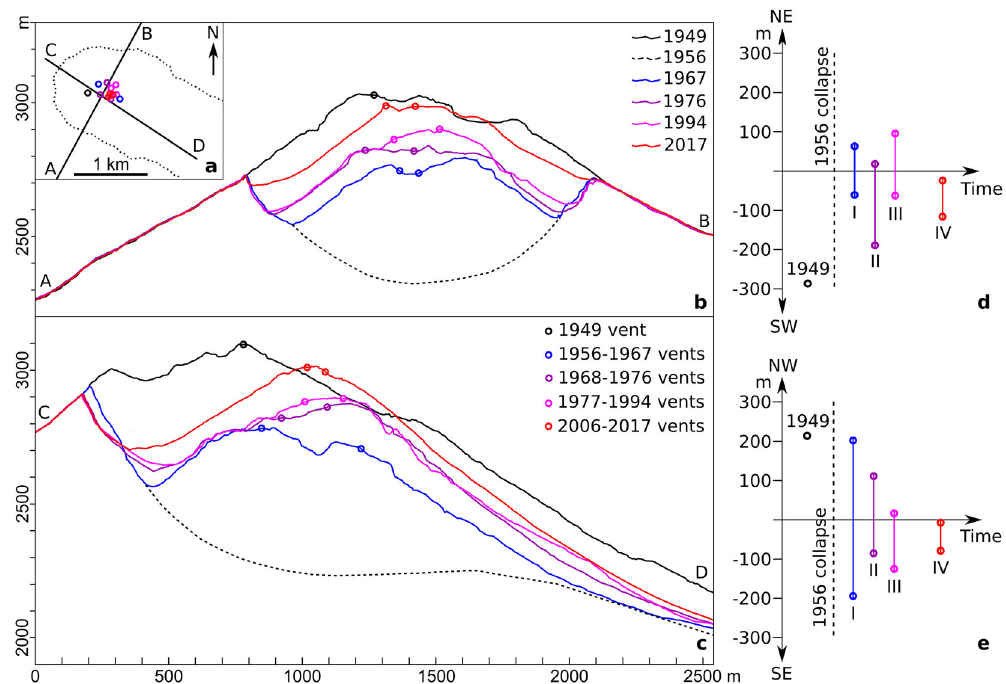
Fig. 6 Gradual vent centralization. a Map with amphitheater outline (dotted line) and farthest eruption centers (circle symbology) identi fi ed at different stages of regrowth in the photogrammetric data sets acquired between 1949 and 2017, and location of pro fi les A – B and C – D. b Pro fi les A – B, across the collapse amphitheater, showing different stages of topography development. c Pro fi les C – D, along the collapse amphitheater, indicating the stages of regrowth, and migration and focusing of vents (as shown by circle symbology). d - e Eruption centers migration along NE – SW and NW – SE directions, highlighting a shift/spread and then re-focusing of vents in the NW – SE pro fi le. The reference is a central point between the two fi rst domes. The post- collapse amphitheater pro fi les were approximated according to ref. 34 . I – IV — stages of regrowth: I — endogenous, II — exogenous (extrusive), III — exogenous (extrusive – effusive), IV — stratocone formation.